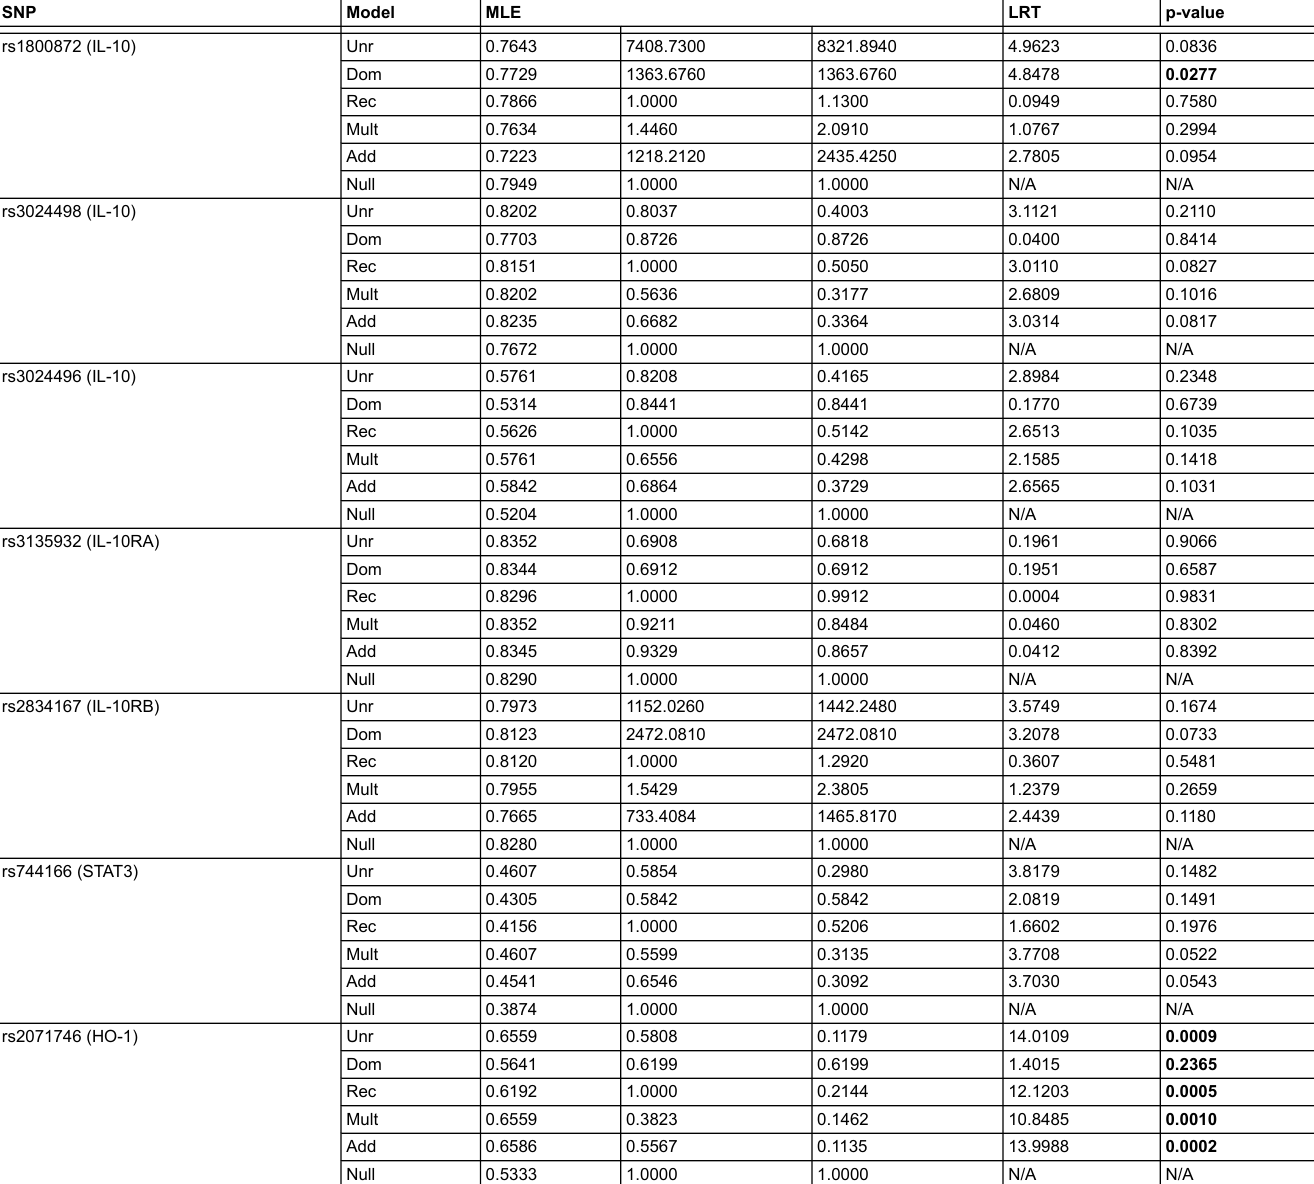
Table 4: Parameter estimation and hypothesis testing summary.